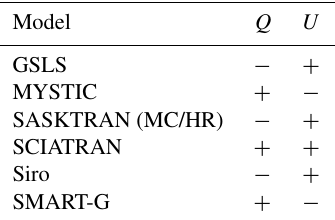
Table 3. Sign that each model’s Stokes parameters were multiplied by to follow the definition of Hovenier et al. (2004). A “ − ” indicates that the component was multiplied by − 1, while a “ + ” indicates the component was